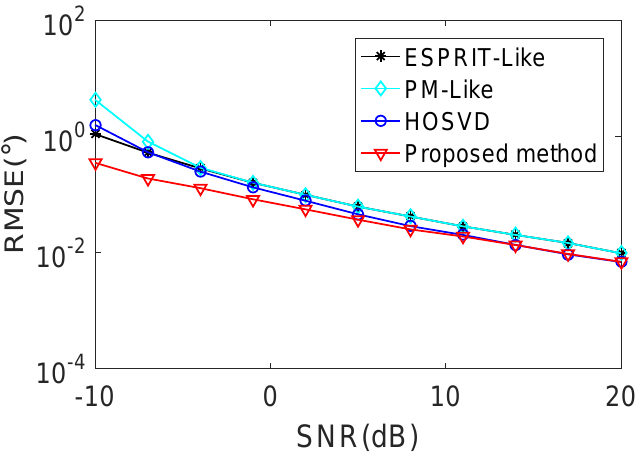
Figure 6. RMSE performance comparison versus SNR with strong mutual coupling.